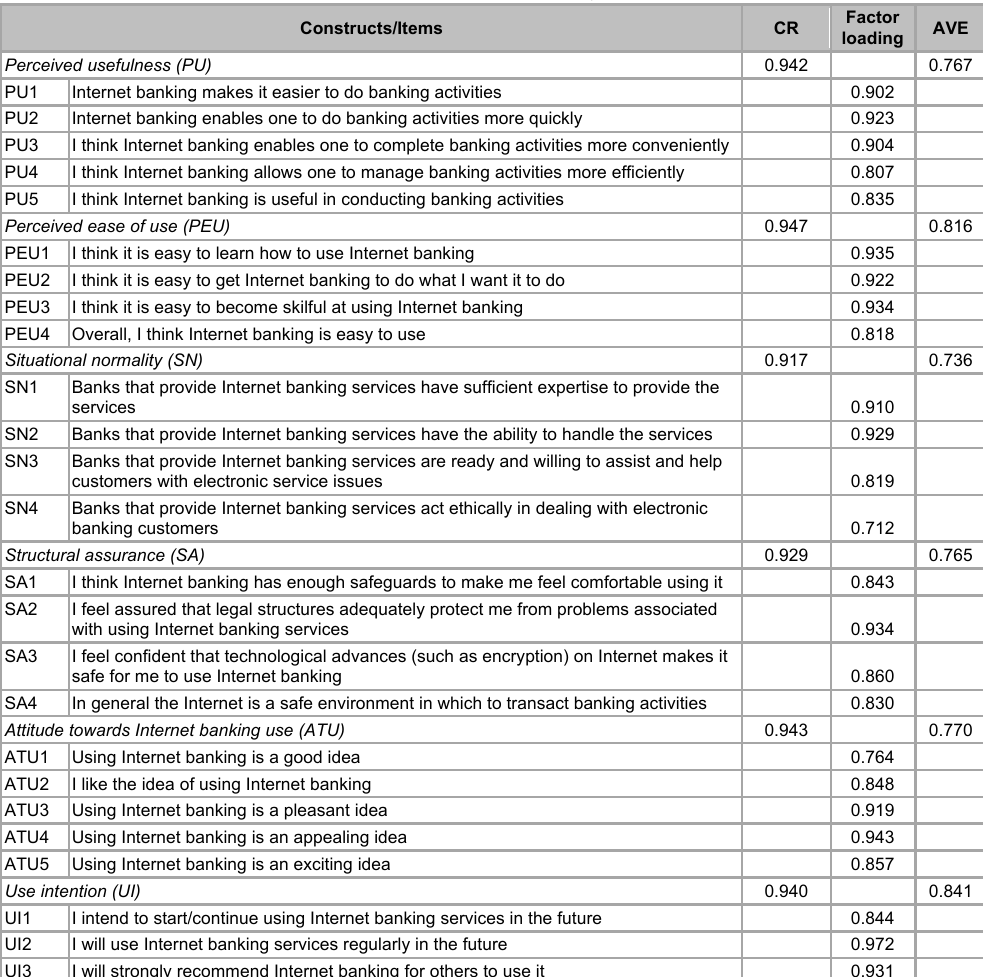
Measurement model